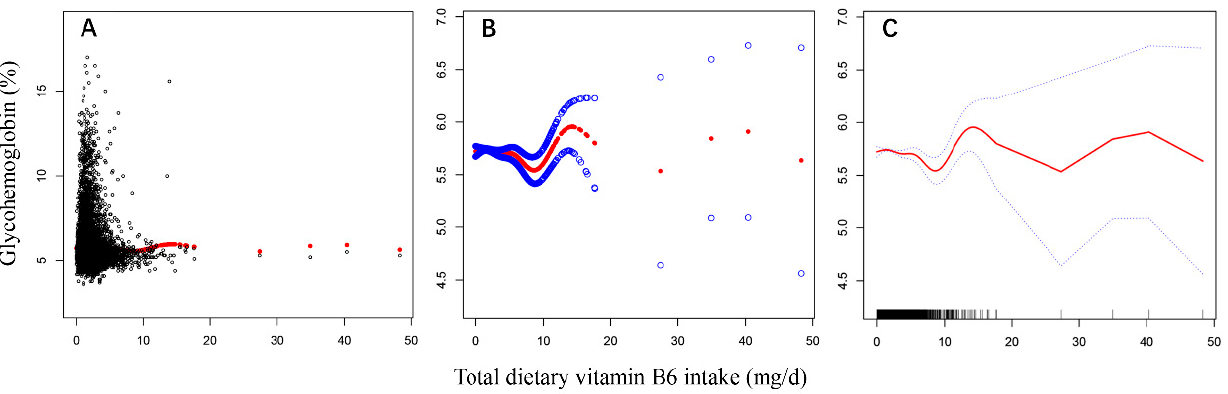
Nutrients 2021 , 13 , x FOR PEER REVIEW